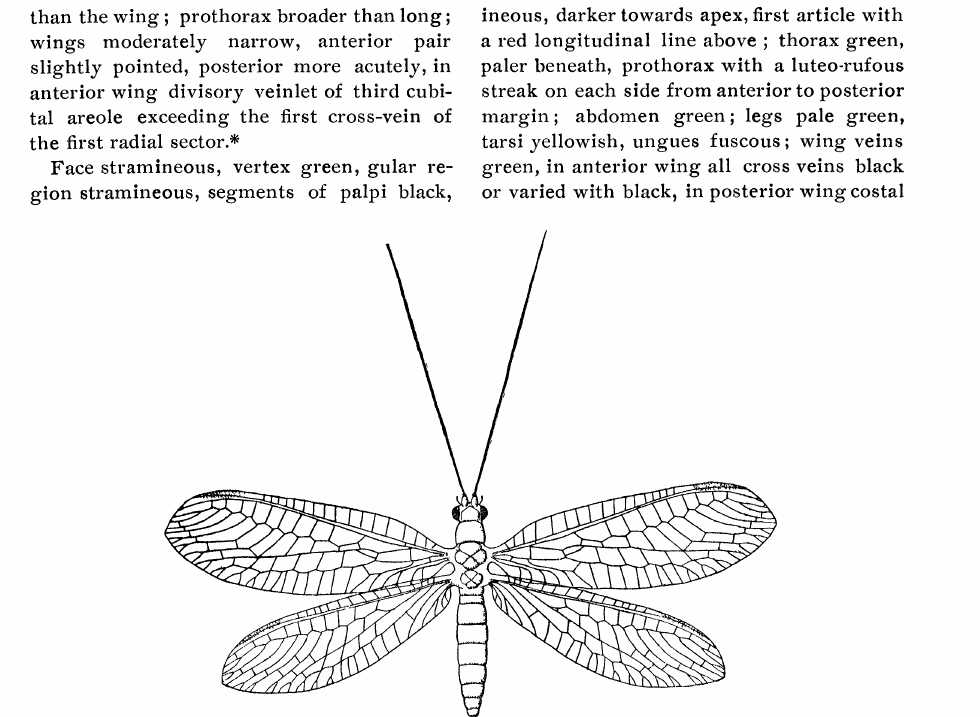
stigma light green. Coloration of alcoholic specimen: green faded to pale yellow, line on first article of antennae fuscous, streak on prothorax faded out, black retained. Four specimens from Laredo, Texas. Au- gust,